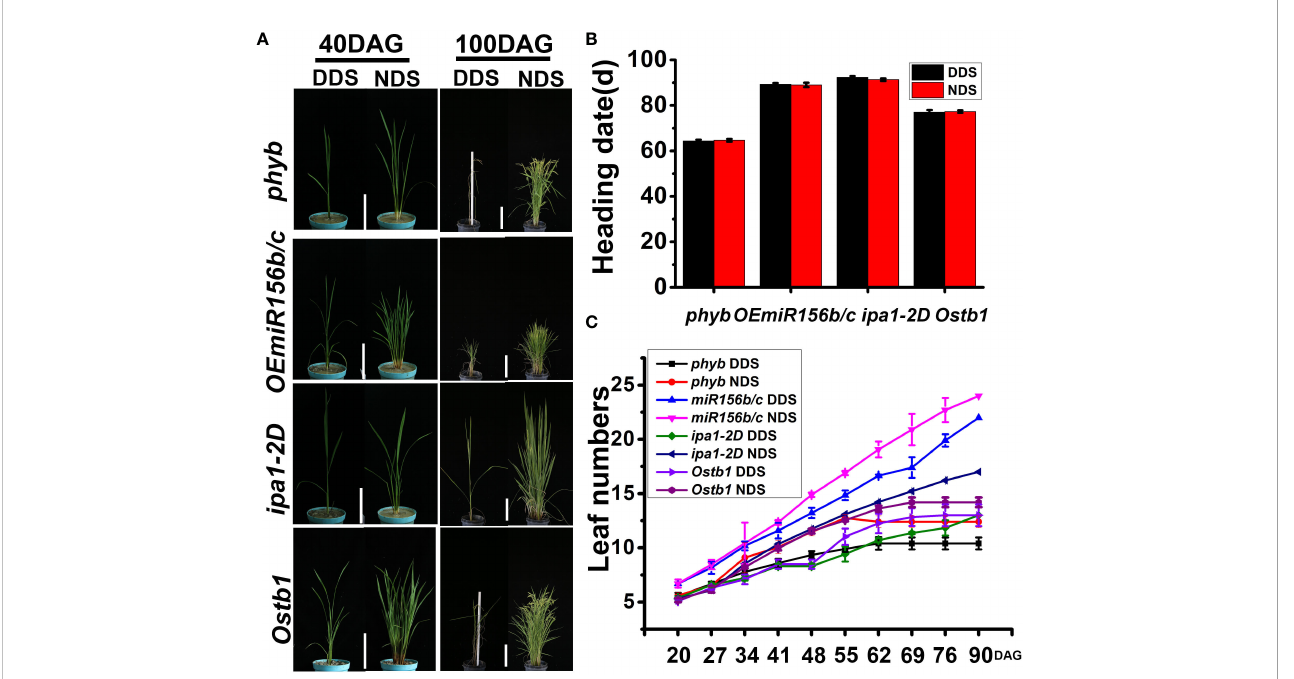
FIGURE 9 (A) A comparison of four mutants (i.e., phyb 、 OEmiR156b/c 、 ipa1-2D 、 Ostb1 ) of the tiller at different stages under DDS or NDS conditions. 40, 100 DAG treatment were photographed. Bar = 15 cm (left) Bar = 20 cm (right). (B) The same heading dates for four mutants (i.e., phyb 、 OEmiR156b/c 、 ipa1-2D 、 Ostb1 ) were observed under DDS conditions. (C) A fewer leaves were observed under DDS compared to NDS conditions in the four mutants (i.e., phyb 、 OEmiR156b/c 、 ipa1-2D 、 Ostb1 ). Error bars represent mean ± SD (n = 3) and different letters indicate signi fi cant differences as indicated by Duncan ’ s multiple range test (p ≤